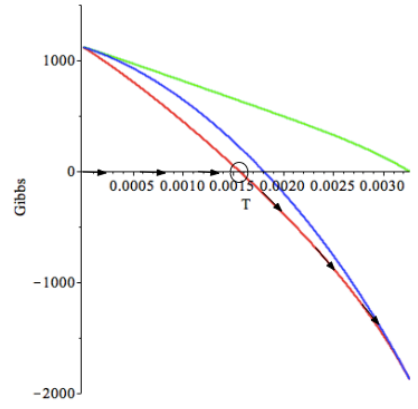
Figure 3 . Gibbs Free Energy with (cid:12)xed potential. The green curve represents G + , corresponding only to the black hole, as a function of temperature. The blue curve represents G c as measured at the cosmological horizon r c and the red curve is that of G Total for the total system i.e. of the black hole in a the de Sitter heat bath. All curves are plotted for P = (cid:0) 0 : 0001 and (cid:8) = 0 : 1.